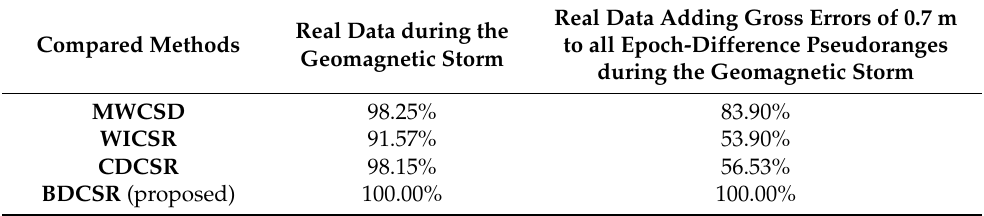
Table 5. The success rates of various compared methods from all BDS satellites at the medium and low latitudes of the CUT0 and ANMG.